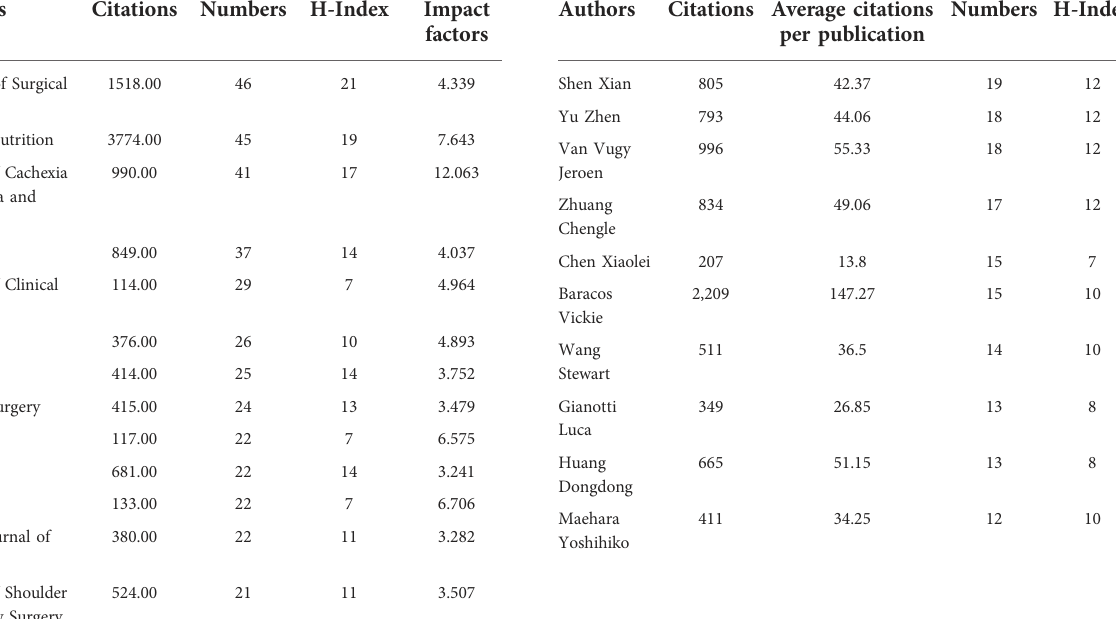
TABLE 3 The journals with more than 20 publications on the relationship between sarcopenia and surgery.